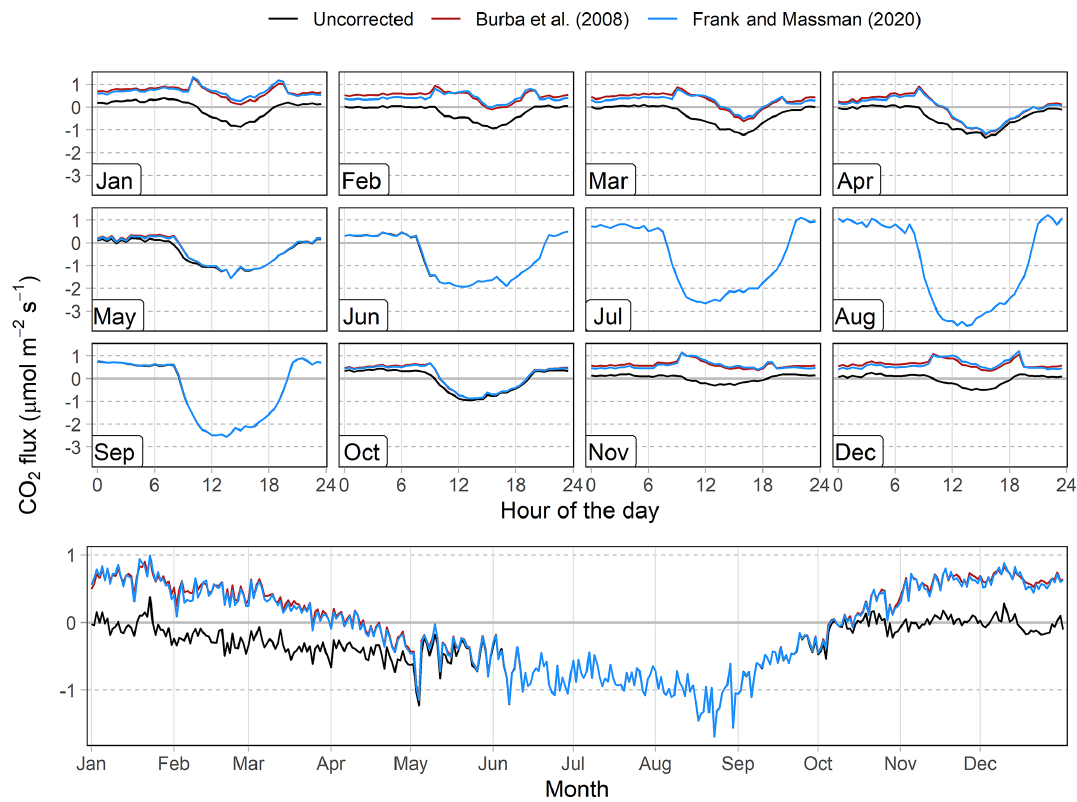
Figure 7. Monthly mean daily course and annual course of daily mean of the CO 2 fluxes of the years 2005–2019 before and after sensor self-heating correction following Burba et al. (2008) and Frank and Massman